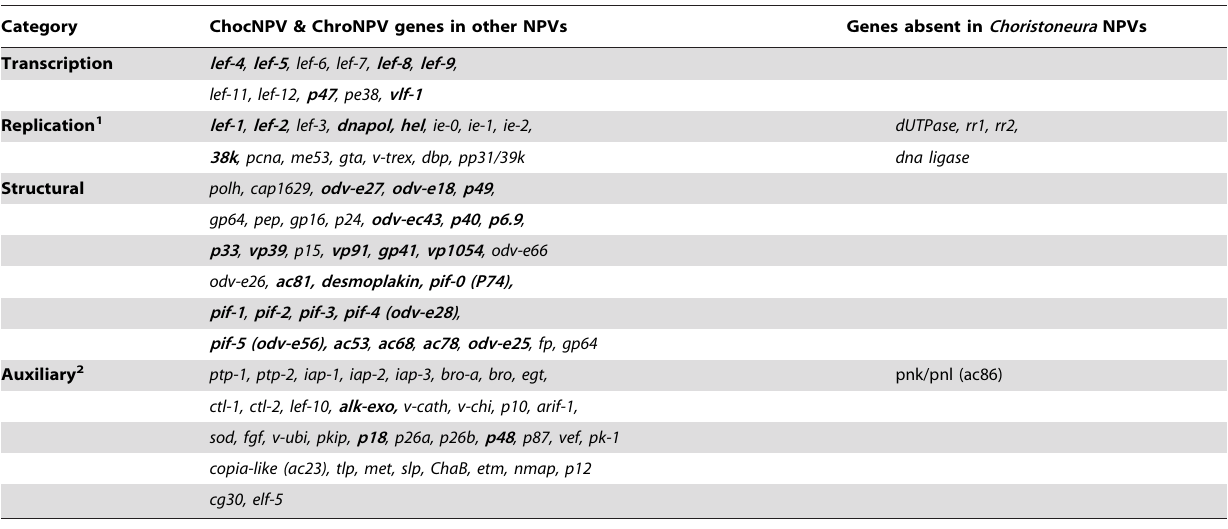
Table 3. ChocNPV and ChroNPV genes present in other baculovirus